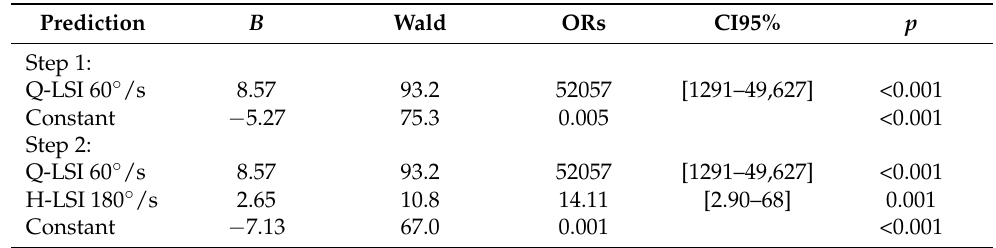
Models of prediction of a return to running, analyzing patient as a unit (limb symmetry